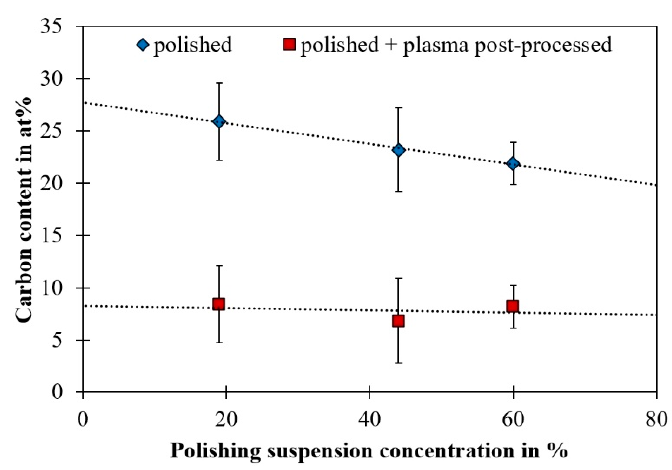
Figure 5. Carbon content of zinc crown glass samples before and after plasma post-processing vs. polishing suspension concentration including trend (dotted line).